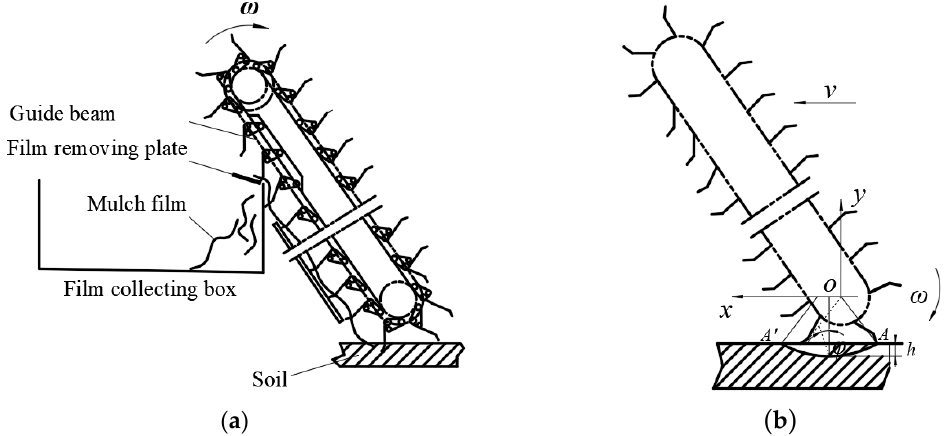
Figure 7. Working process of the film pickup device. ( a ) Picking film process diagram, ( b ) Motion diagram of the pick ‐ up hook tooth.